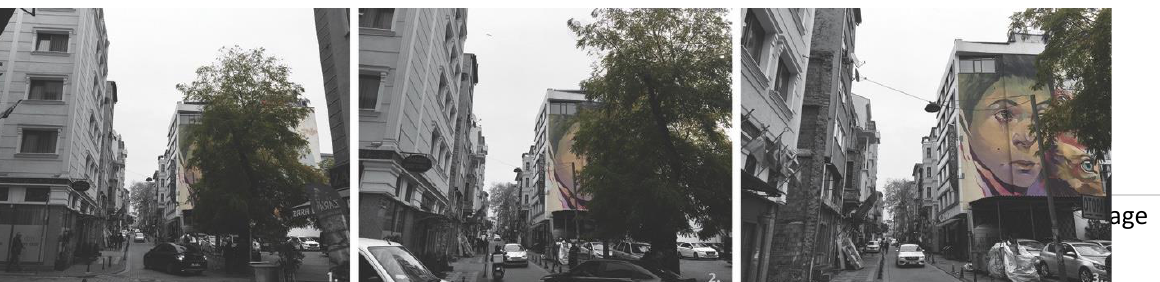
Figure 14 Within the serial vision, while the tree screens the mural standing behind from a distance, the successive change in the observer’s position makes the mural visible without any barrier: The early stage, in which the mural is barely seen, stimulates the sense of anticipation, and makes the perception more effective.